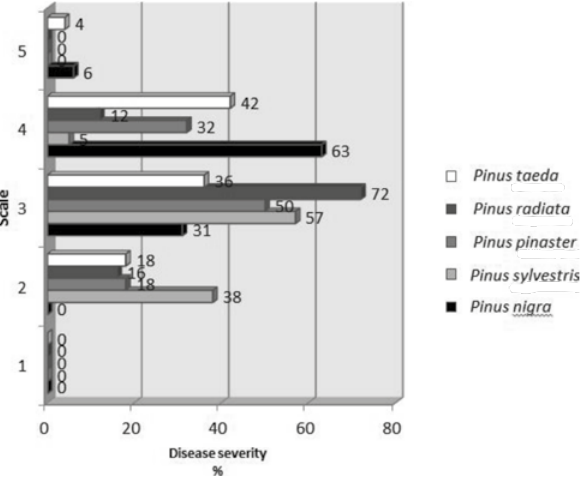
Figure 1. Percentage disease severity in each disease scale group for different Pinus